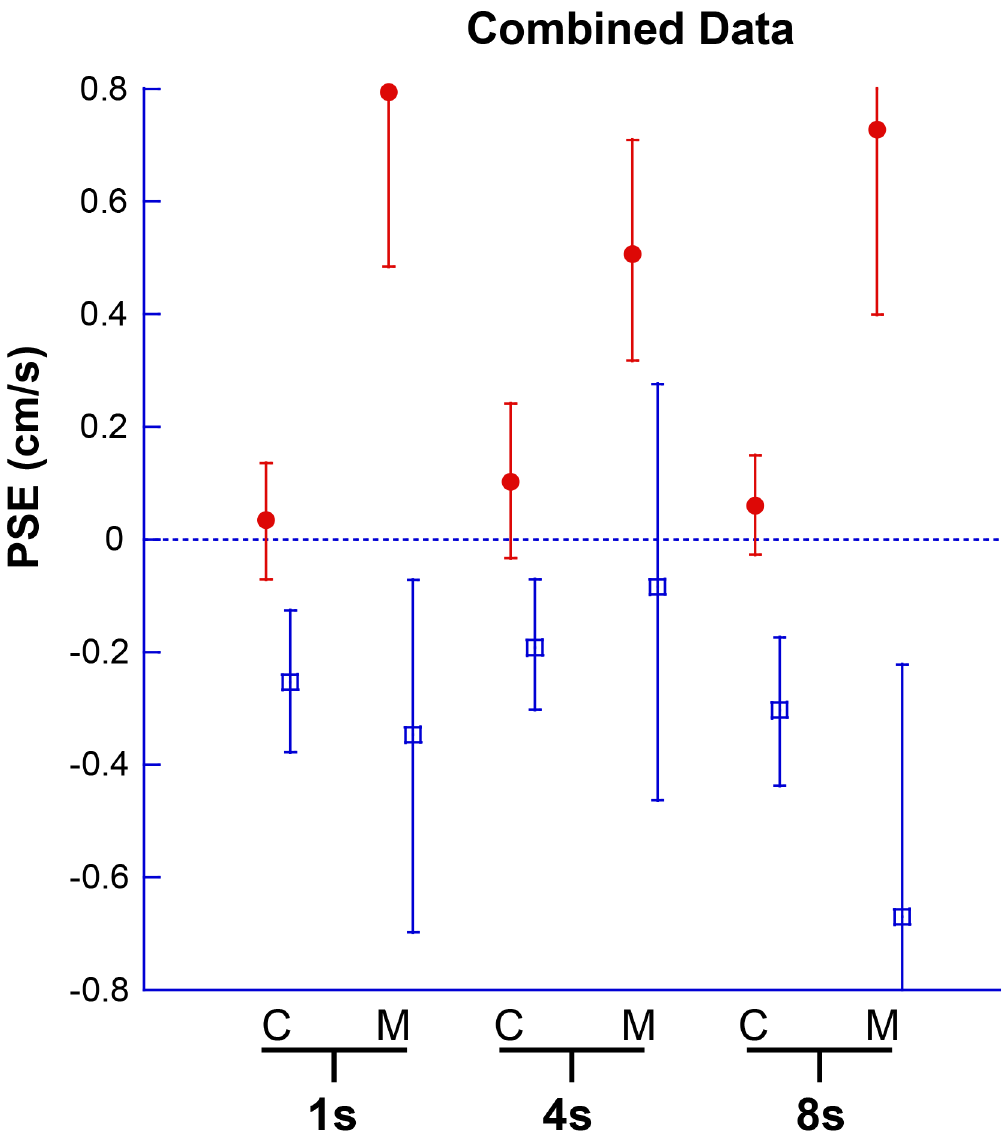
Fig 11. Combined Data for Experiment 2. Looming VFM are represented with filled red circles, receding VFM are represented by blue open squares. A positive PSE indicates that neutral motion would be perceived as forward self-motion. Error bars represent 95% CI.